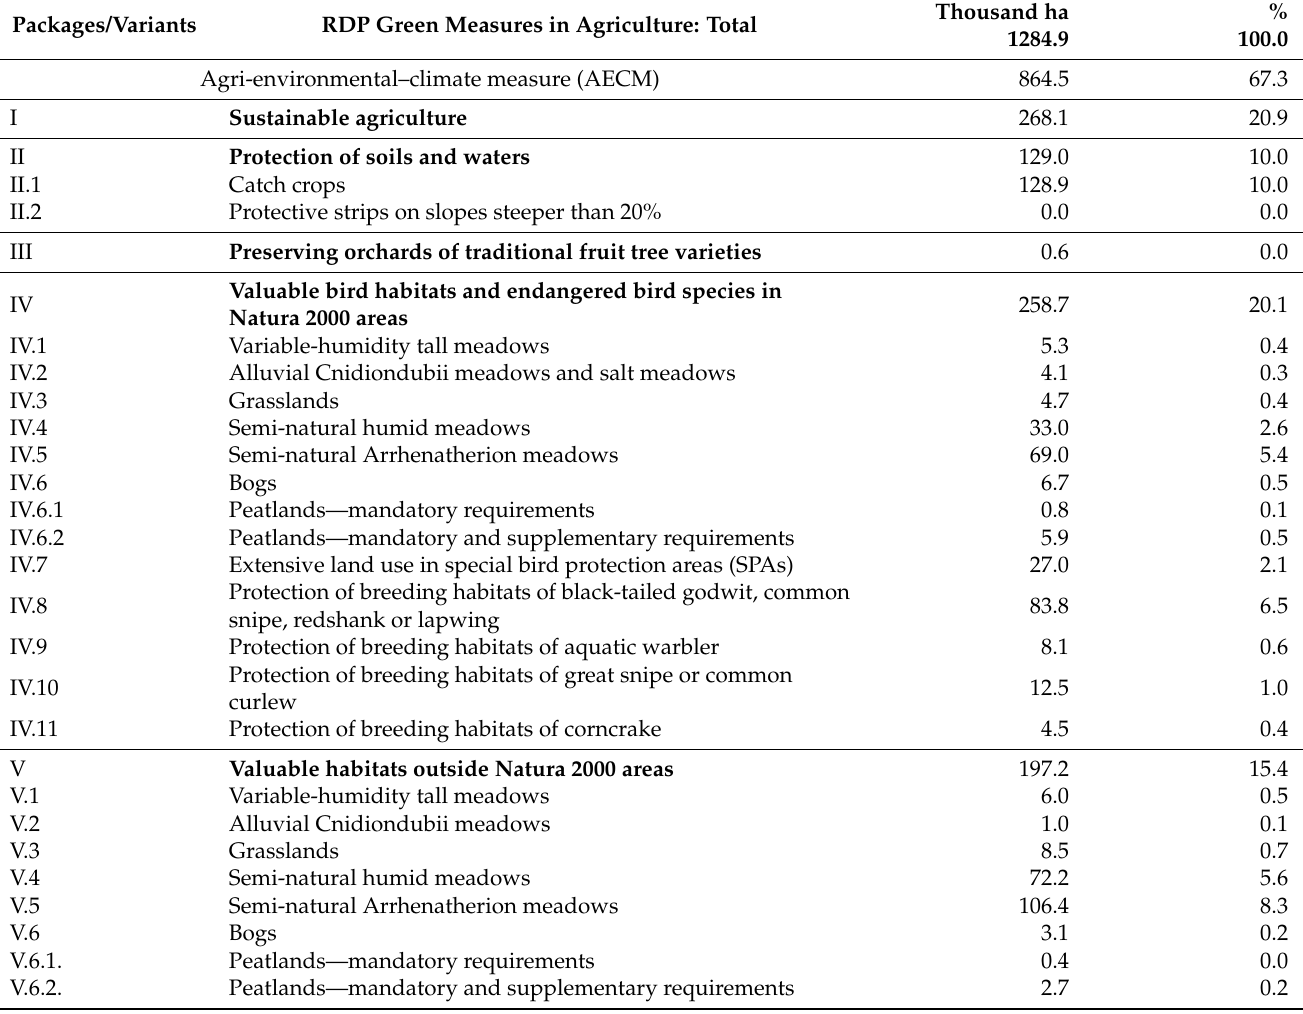
Table A1. Pro-environmental agricultural payments: forms of support and areas covered by subsidies.